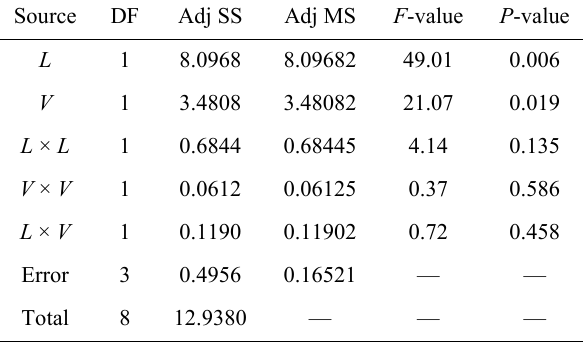
Table 6 Analysis of variance for RMS roughness ( S q